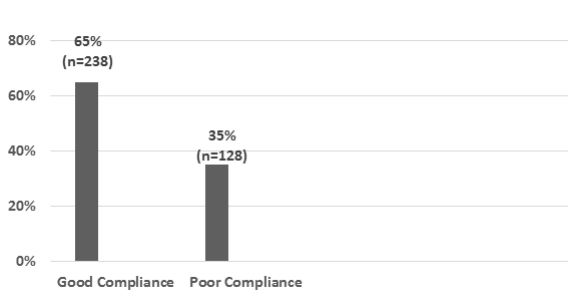
Figure 1. Distribution of patients in relation to the extent of compliance to treatment (N=366)